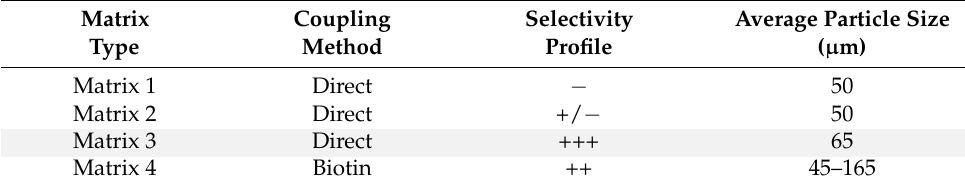
Figure 3. Lead affinity ligand candidate selection. ( A ) Adsorber screening using streptavidin agarose beads functionalized with biotinylated ligands (A to E). Transducing units’ depletion (blue bars) and elution (yellow bars) comparison between the different ligands. The AAVX ligand was included as a negative control. ( B ) Transduction units’ recovery comparison between A, B, and E adsorber prototypes at the highest ligand density (++++). The effect of ligand density was evaluated for ligand B as it was shown to be the leading candidate. Ligand densities are ordered from the lowest (+) to the highest (++++) value evaluated. Color code: the four bars colored with shades of green correspond to different ligand densities of ligand A, orange correspond to ligand B and purple bar to ligand E. Table 1. Properties of the matrices explored for the establishment of a new affinity